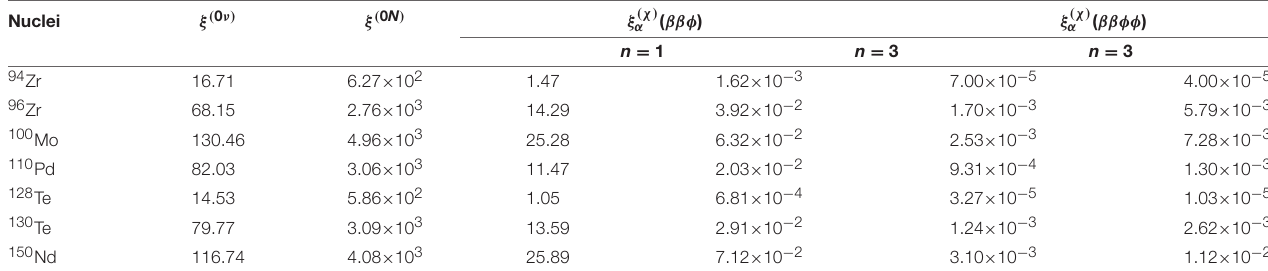
TABLE 8 | Nuclear sensitivities ξ ( 0 ν) , ξ ( 0 N ) , ξ (χ) α ( ββφ ) and ξ (χ) α ( ββφφ ). Nuclei